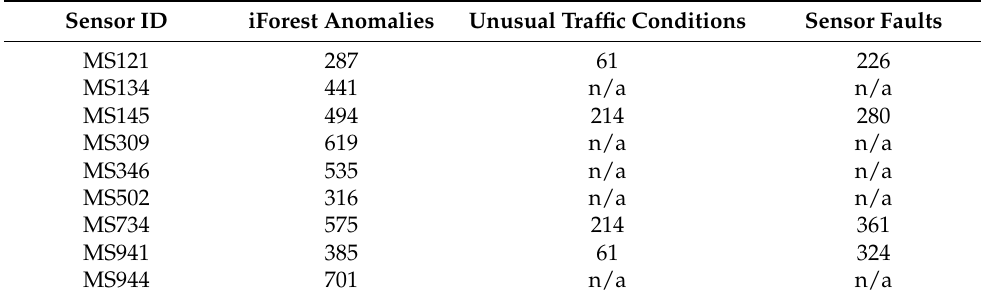
Table 5. Anomalies detected by the iForest algorithm.